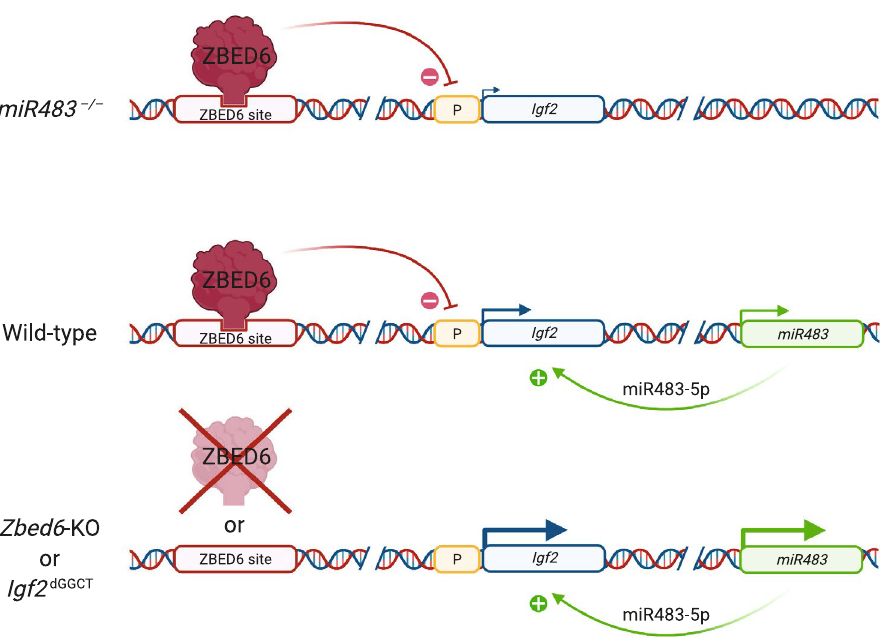
Figure 6. Schematic illustration showing the interaction between ZBED6 and the Igf2 - miR483 locus and how ZBED6 suppresses expression of Igf2 and miR483 , whereas miR483-5p enhances expression at the Igf2 - miR483 locus. The size of hooked arrows indicates level of expression. P, promoter. Figure created with